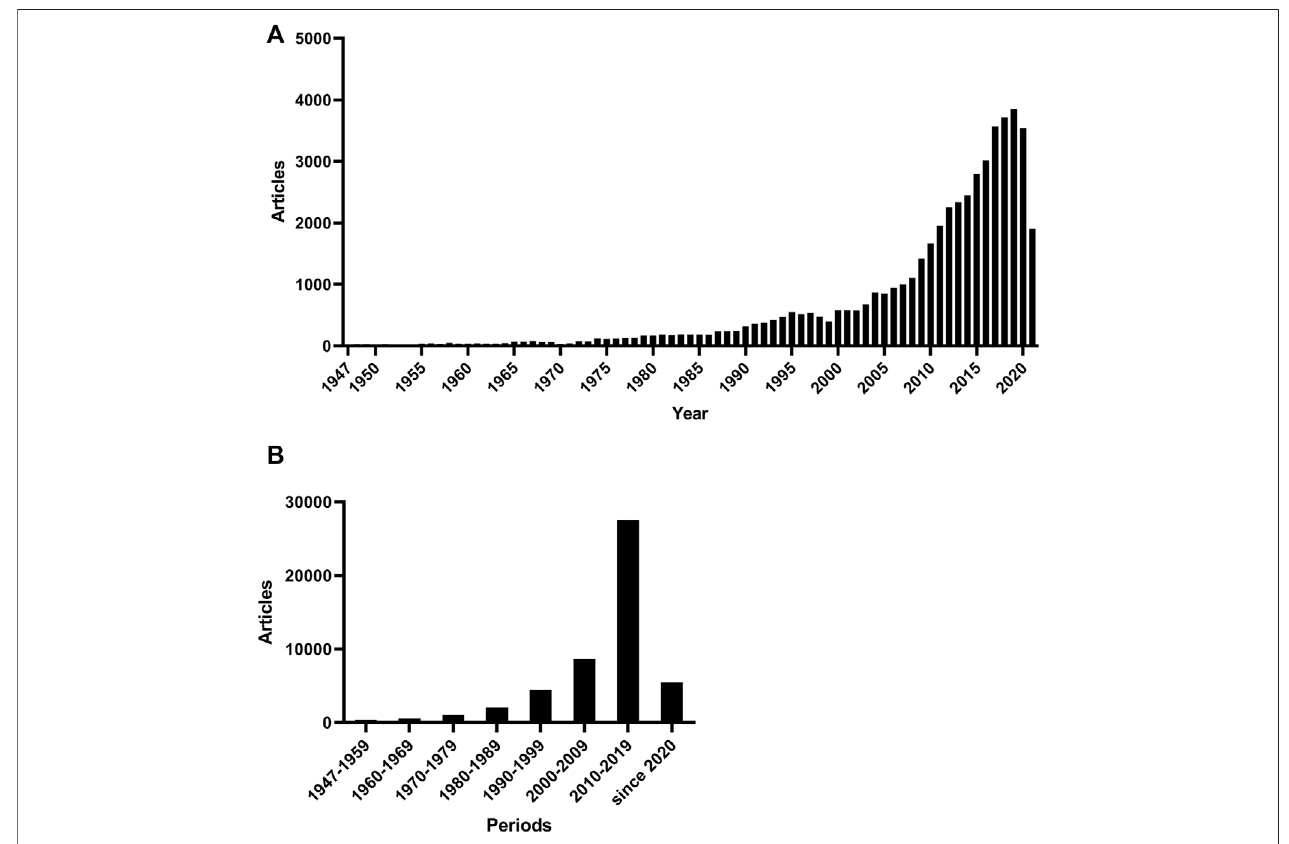
FIGURE 3 | The number of articles by year of